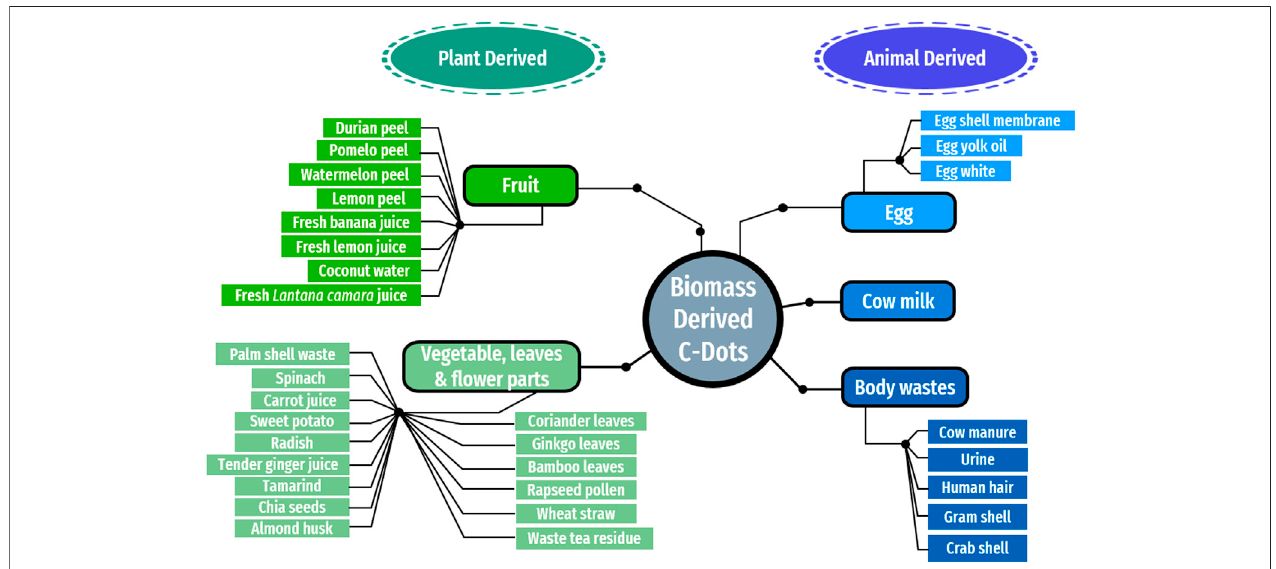
FIGURE 1 | C-Dots precursors from